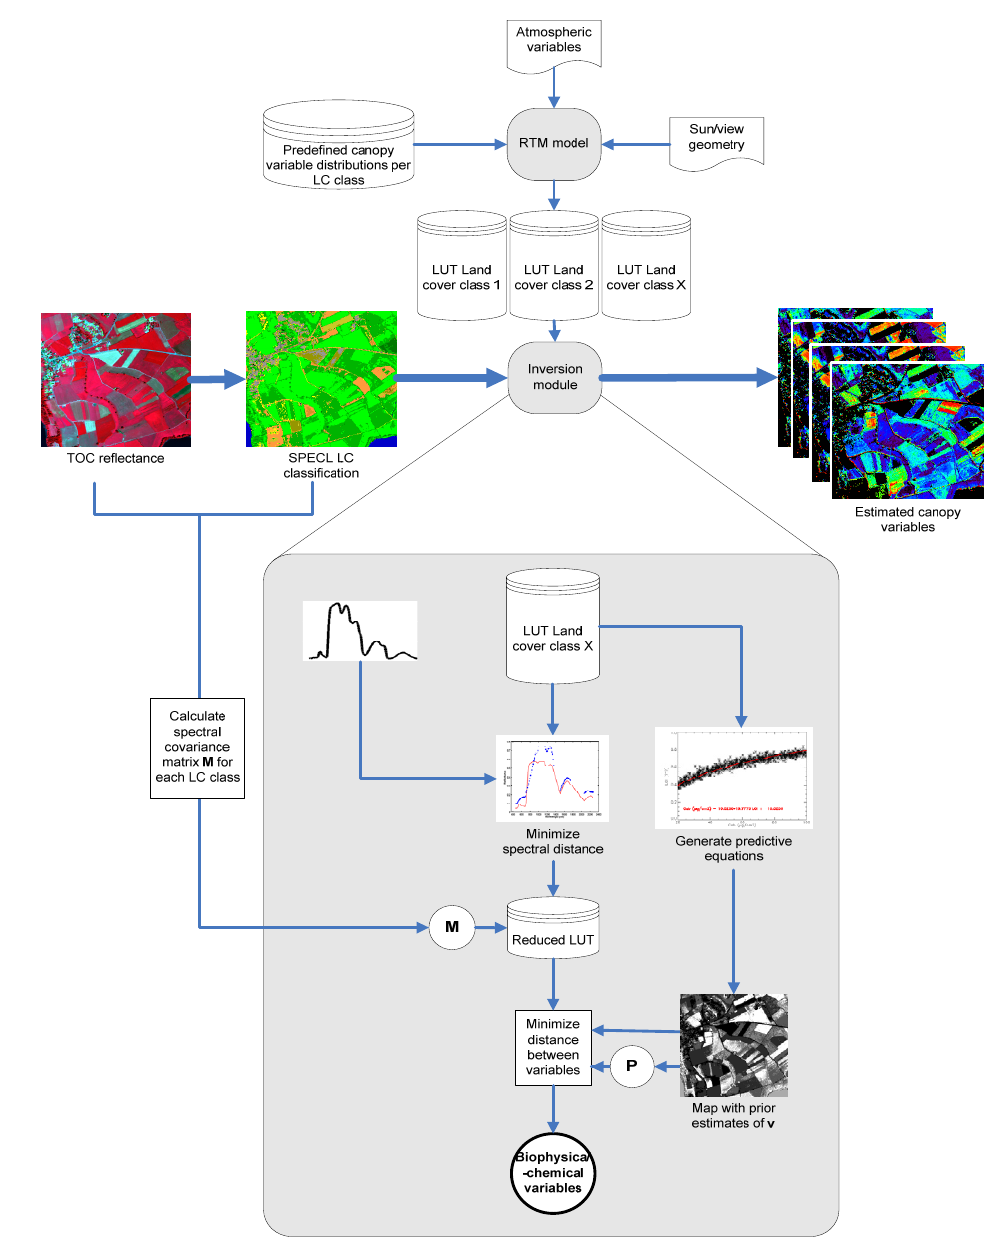
Figure 1. Overview of CRASh inversion scheme. The upper part shows the general sequence, the grey box shows the inversion approach